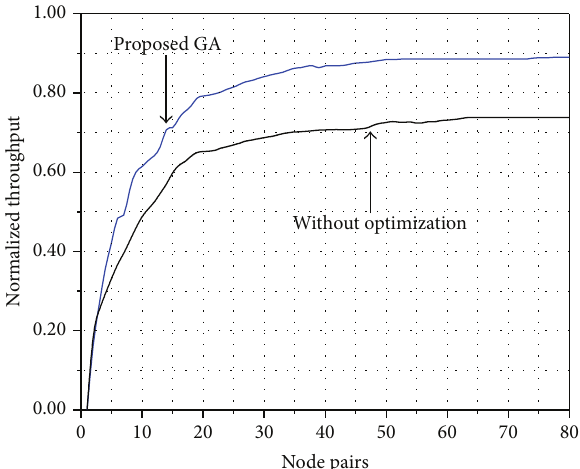
Figure 6: Throughput of CDMA ad hoc network using genetic algorithm